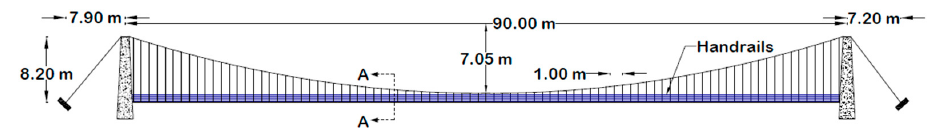
Figure 4. Elevation of the footbridge.